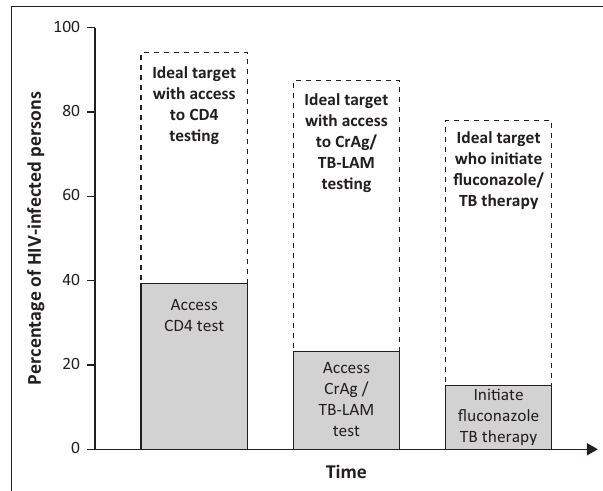
FIGURE 1: Schematic detailing comparison between ideal AHD targets and current AHD indicator